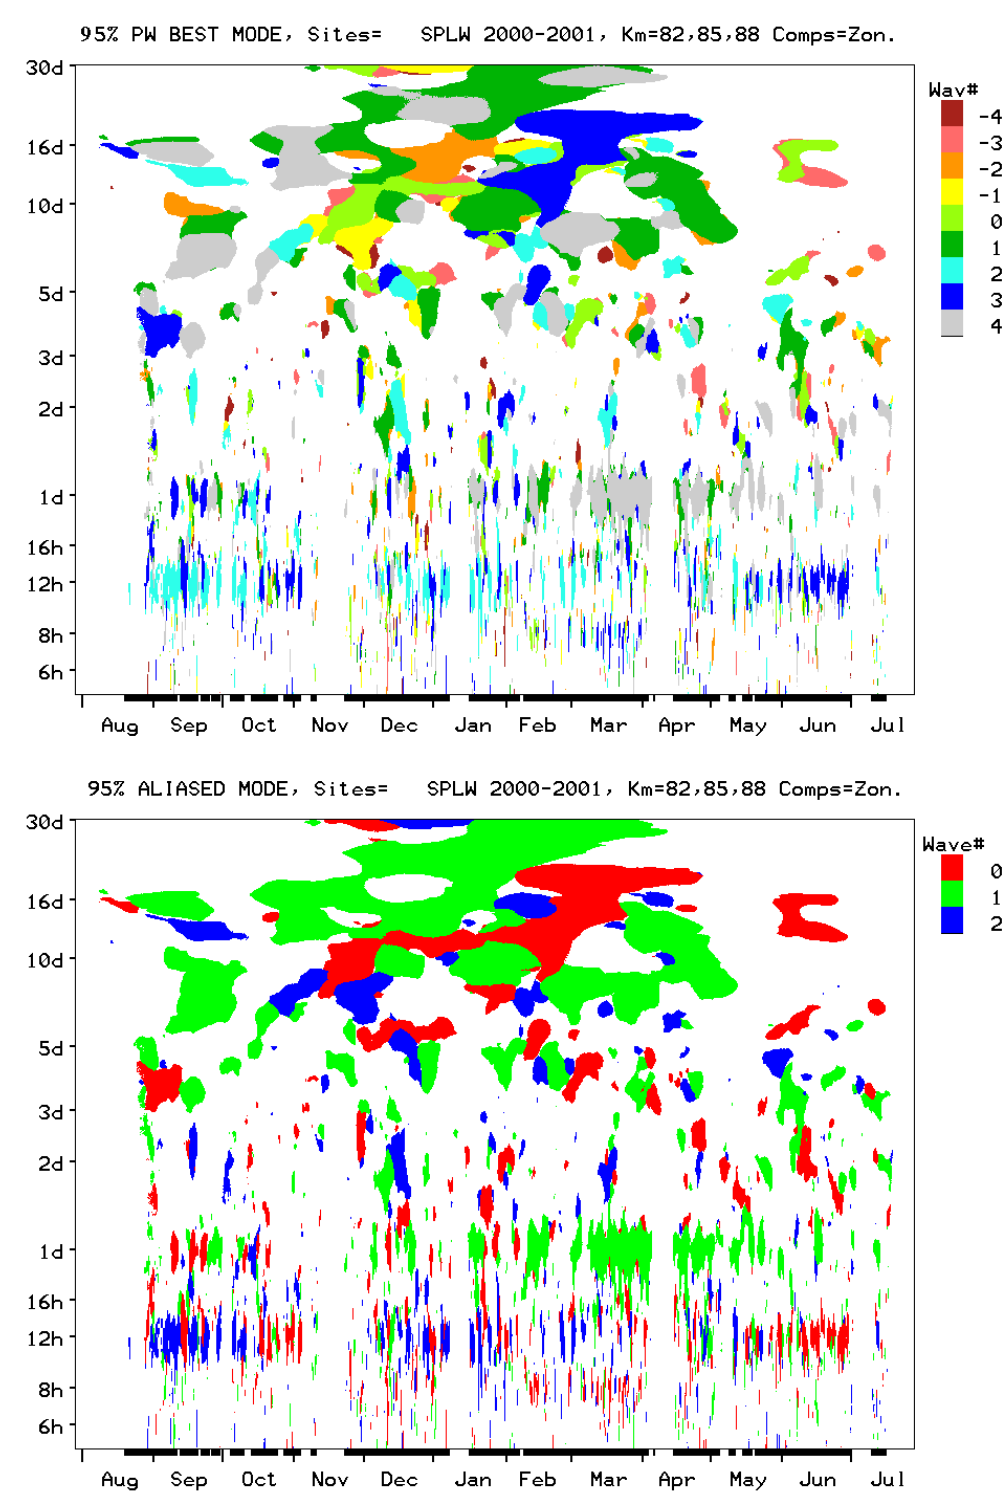
Fig. 5. Annual contours of the preferred wave number (at the 95% significance level) as functions of frequency and time for the zonal (EW) component of the wind and for the 4 locations of Fig. 4. The data from 3 heights (82, 85, 88km) are used for added statistical stability. In (a) all possible wave numbers from 0 to +/ − 4 are plotted, while in (b) all aliasing possibilities are accepted and folded into the 0, 1, 2 modes (see Sect.